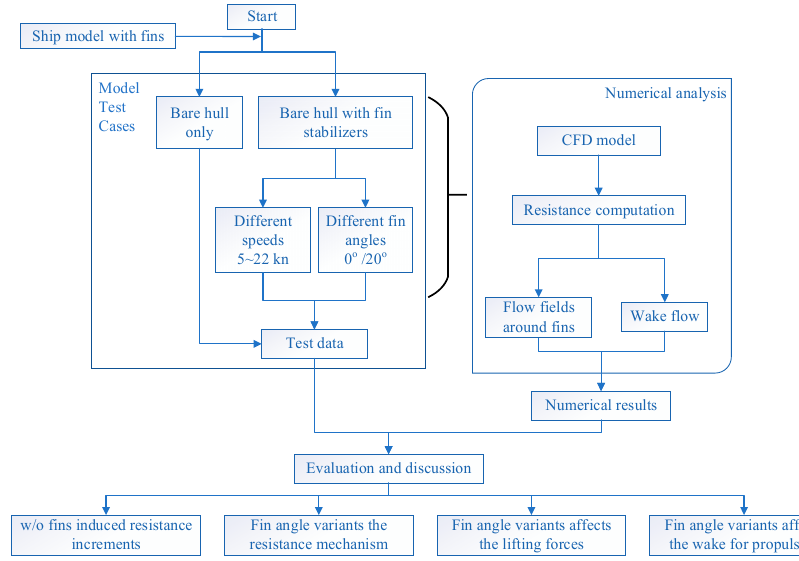
Figure 2. Flowchart of the study process.